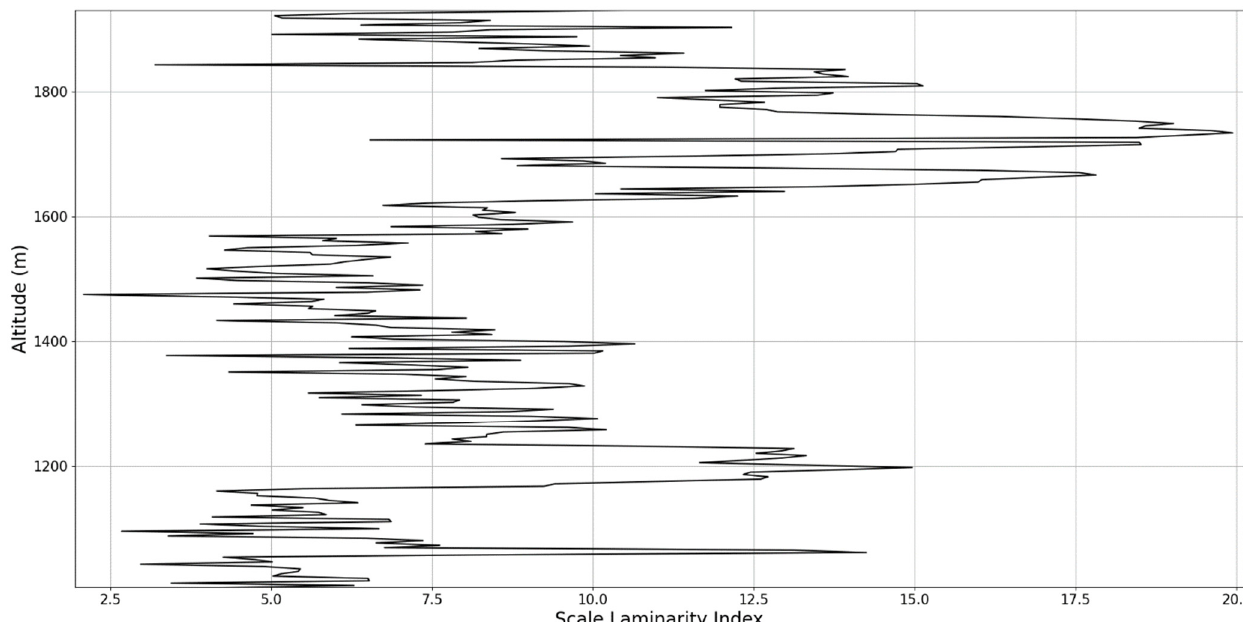
Figure 30. Zoomed-in scale laminarity index profile plot corresponding to point B.